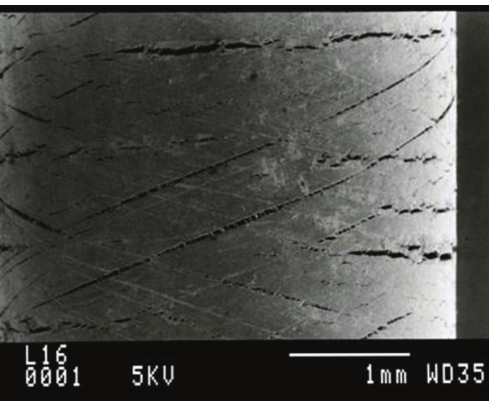
Figure 12: The same sample as shown above at a slightly higher magnification revealing how the cracks followed the grinding marks on the sample after a slow strain-rate test at 45 ◦ C and 800 kPa 25% CO–75% CO 2 .